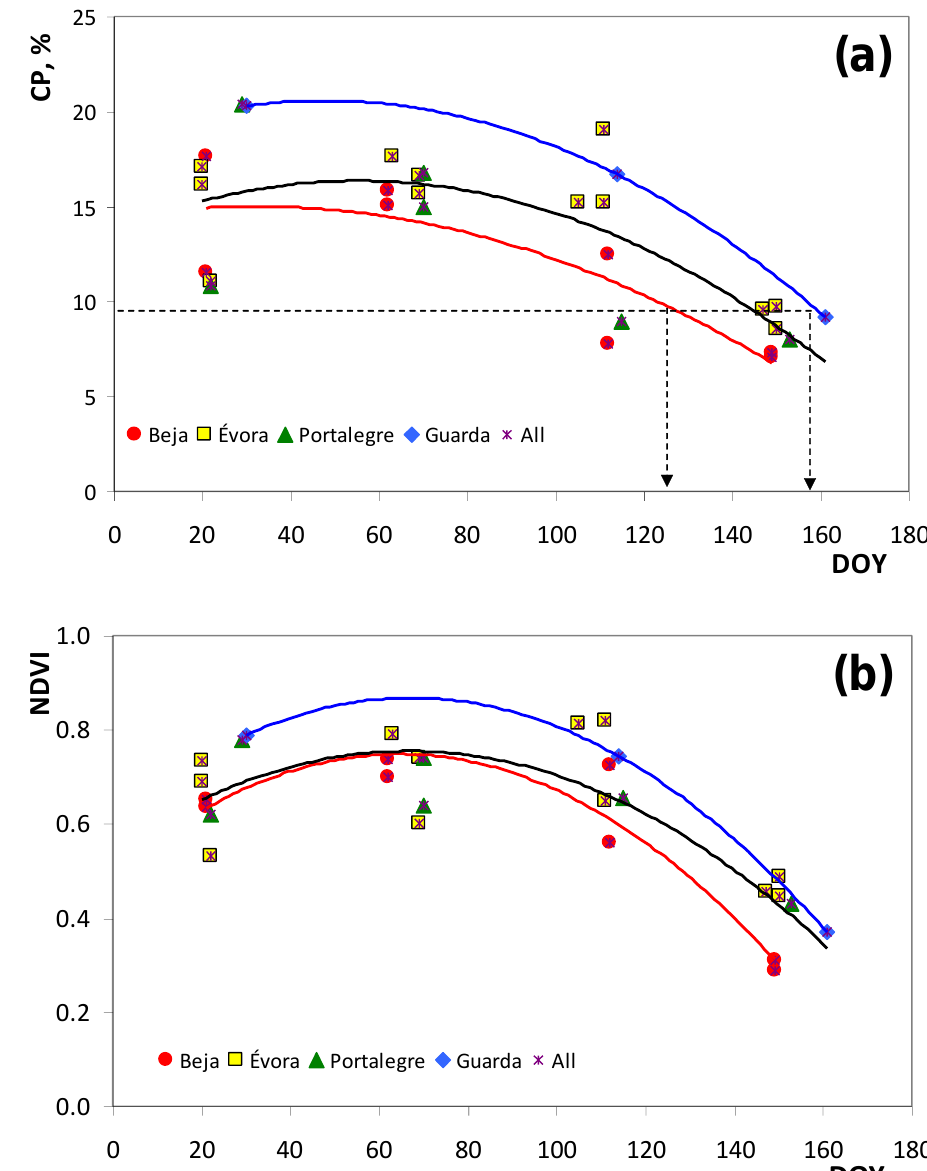
Figure 5. Crude protein (CP; ( a )) and normalized difference vegetation index (NDVI; ( b )) patterns of the pasture by districts, between January and June 2020.